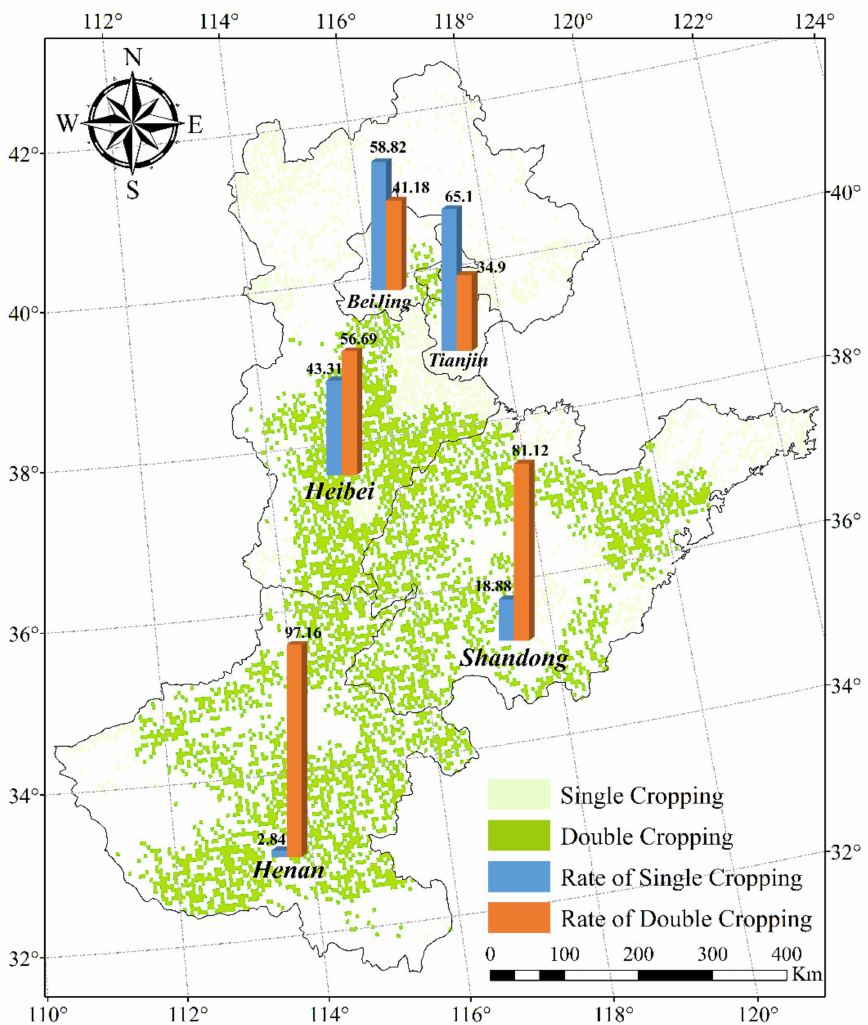
Figure 9. Spatial patterns of cropping systems used on the NCP from 1982 to